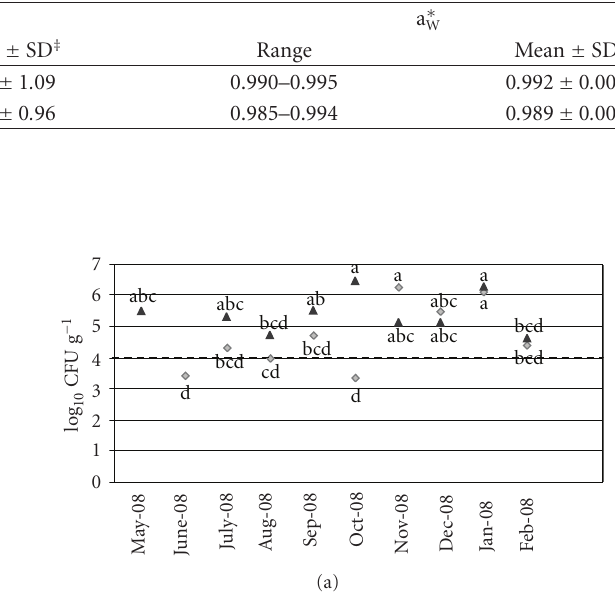
Table 1: Values of pH and a W from brewer’s grain at days 0 and 7 of storage.